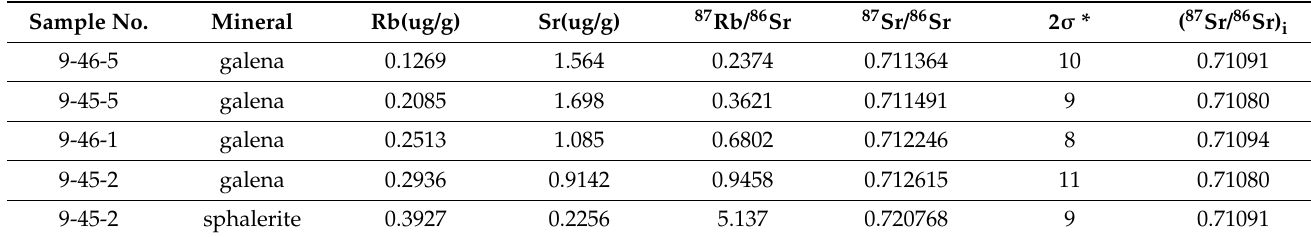
Table 1. Rb-Sr isotopic analyses of sulfides from the Yingfang Pb-Zn-Ag deposit. Sample No.